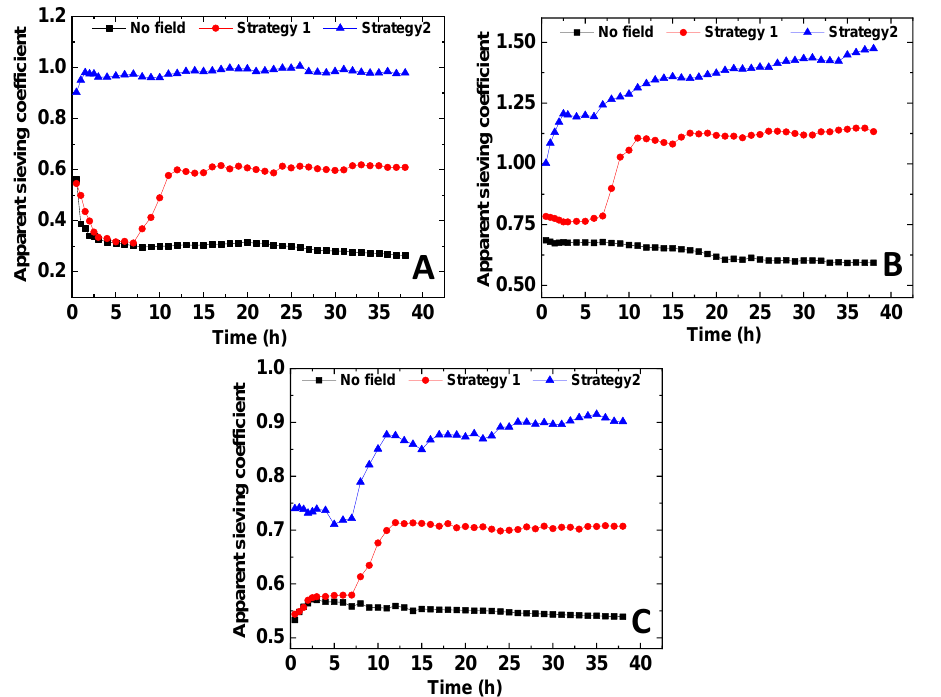
Figure 7. The apparent sieving coefficient versus time for ( A ) membrane holding NP spheres prepared by PISA techniques, ( B ) membranes prepared from NIPS procedure containing PMAA 47 -coated NPs, and ( C ) membranes from NIPS procedure containing DMSA-coated NPs, obtained at a TMP of 3 bar.